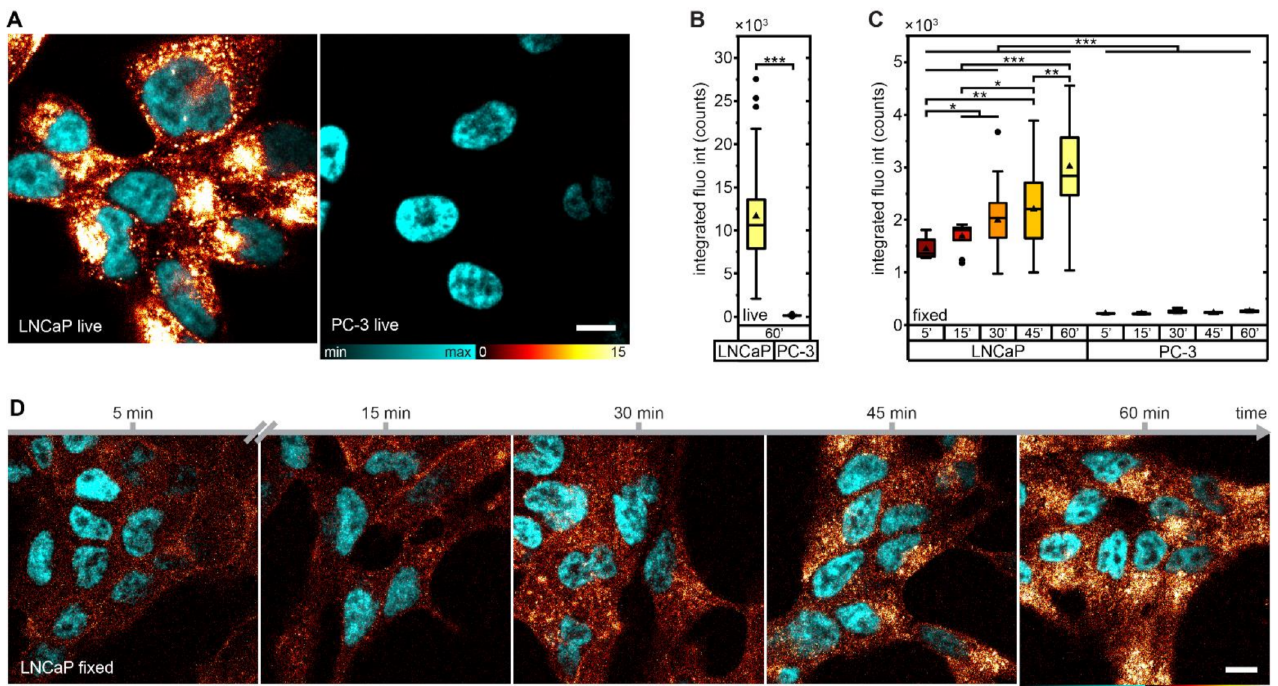
Figure 2. In vitro fluorescence imaging of PSMA-927. ( A ) Confocal images of living LNCaP and PC-3 cells after incubation with 50 nmol/L compound for 60 min; scale bar, 10 µ m. ( B ) Integrated fluorescence intensity of LNCaP and PC-3 cells after incubation with 50 nmol/L compound for 60 min without fixation and ( C ) for 5/15/30/45/60 min with PFA fixation. Note that imaging parameters differed between live and fixed cell imaging and thus the integrated fluorescence intensity could not be directly compared (LNCaP: live 60 min n = 54, fixed 5 min n = 10, fixed 15 min n = 10, fixed 30 min n = 21, fixed 45 min n = 22, fixed 60 min n = 19; PC-3: live 60 min n = 32, fixed 5 min n = 5, fixed 15 min n = 5, fixed 30 min n = 5, fixed 45 min n = 5, fixed 60 min n = 11). Significance: * p < 0.05; ** p < 0.01; *** p < 0.001. ( D ) Confocal images of fixed LNCaP cells after incubation with 50 nmol/L compound for 5/15/30/45/60 min; scale bar, 10 µ